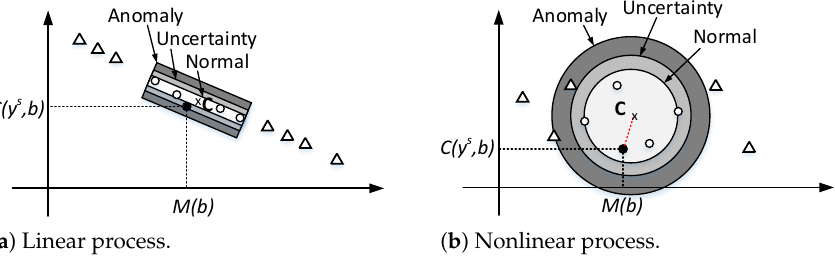
Figure 3. Example design of the mass function. Empty circles denote nearest neighbours, the new attested element is illustrated with a filled circle, and non-selected elements are denoted by